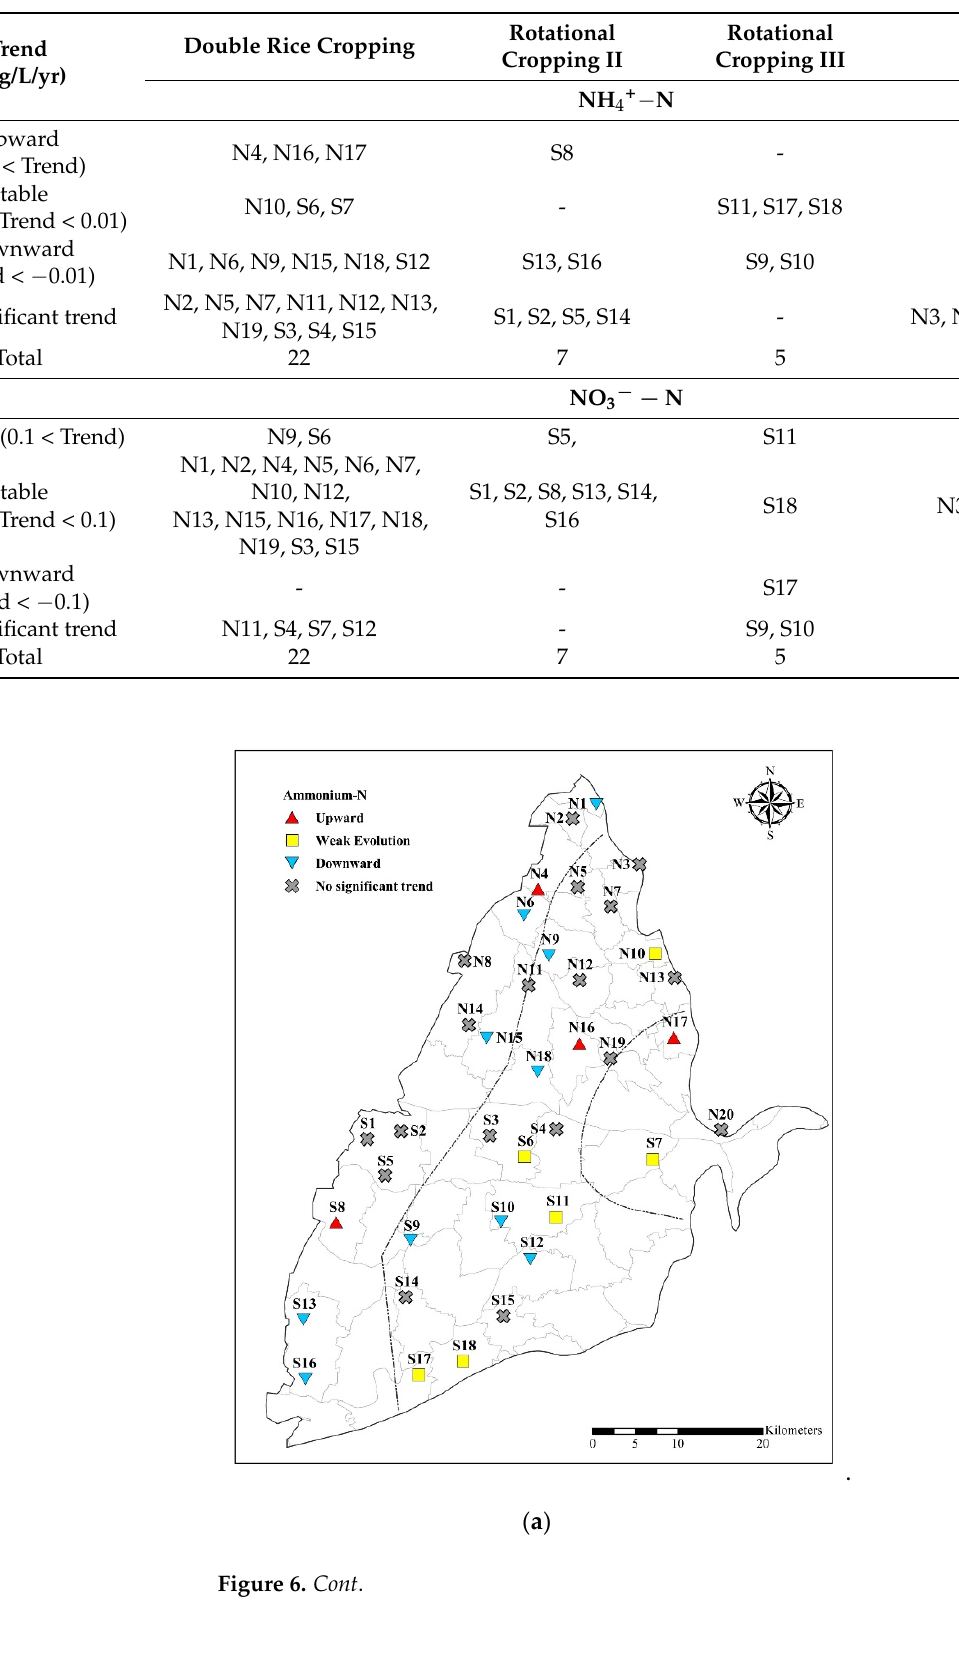
Table 4. The MK test coupled with slope estimation under various classifications.